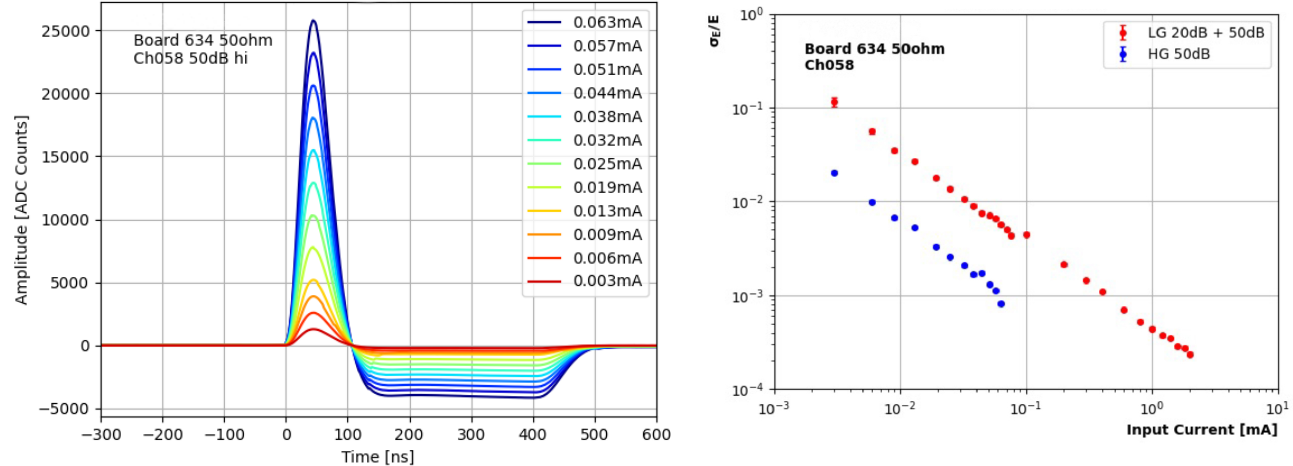
Figure 6. Plot of reconstructed LAr pulses from the slice testboard across the full dynamic range ( left ), and the corresponding energy resolution σ E / E as a function of input current ( right